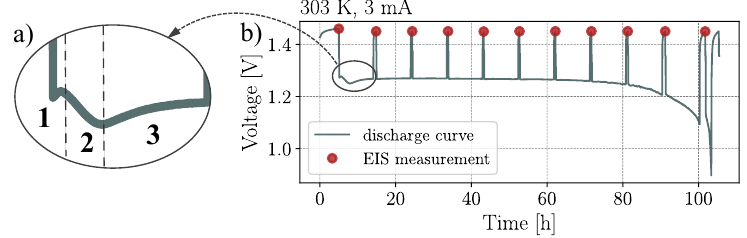
Figure 1. Discharge curve of a ZAB ( b ) at 303 K with a constant current of 3 mA. The red circles indicate the point where the EIS measurement was taken. ( a ) Illustrates the inhomogeneous discharge behavior separated in three different sub-processes during the discharge of the first 10%